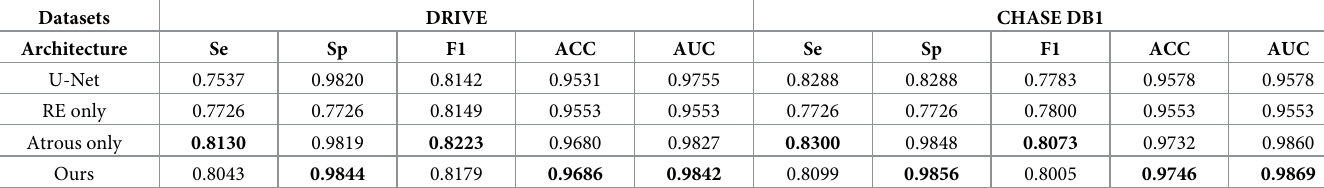
Table 3. Experimental result on DRIVE and CHASE DB1.